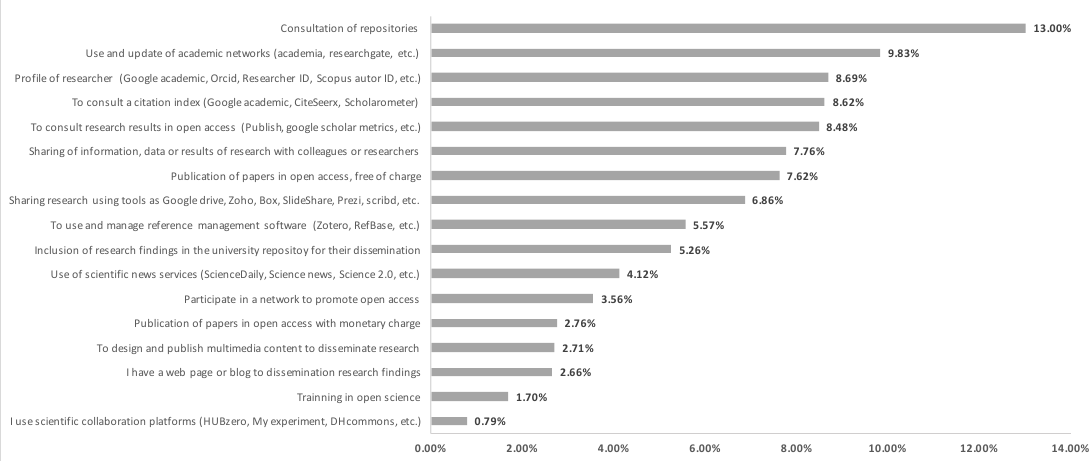
Figure A3. The main implications of open science, according to Colombian researchers. Information 2018 , 9 , x FOR PEER REVIEW